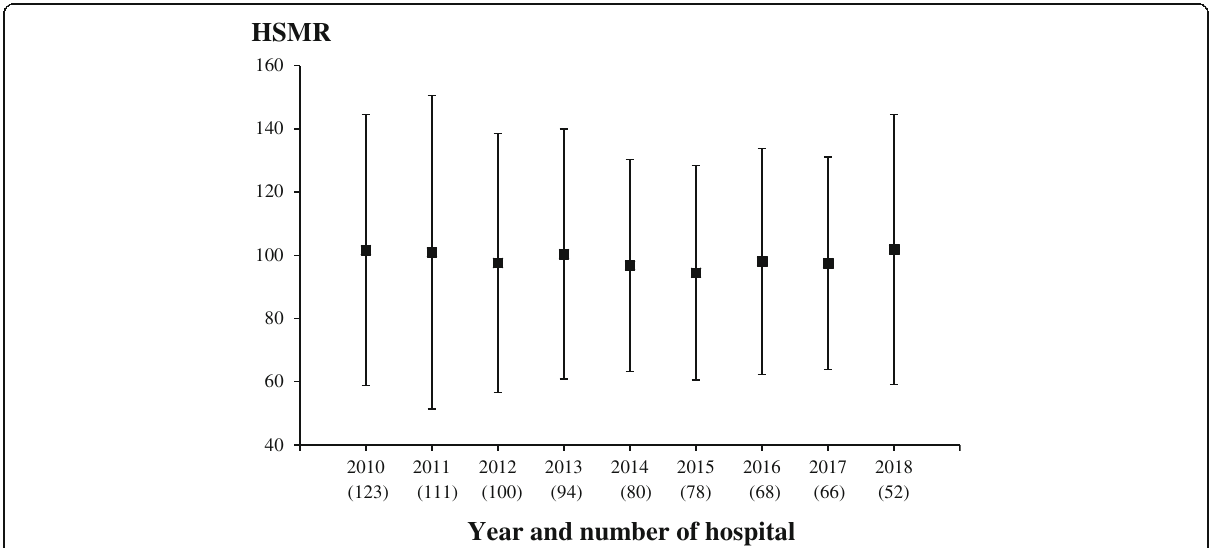
Fig. 1 Mean and SD of the HSMR for pneumonia for each year. HSMR hospital standardized mortality ratio